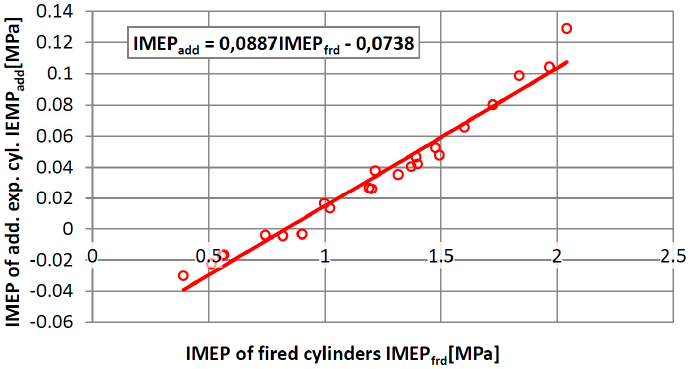
Figure 11. The Indicated Mean Effective Pressure in the cylinders of additional expansion as a function of the Indicated Mean Effective Pressure in the fired cylinders.